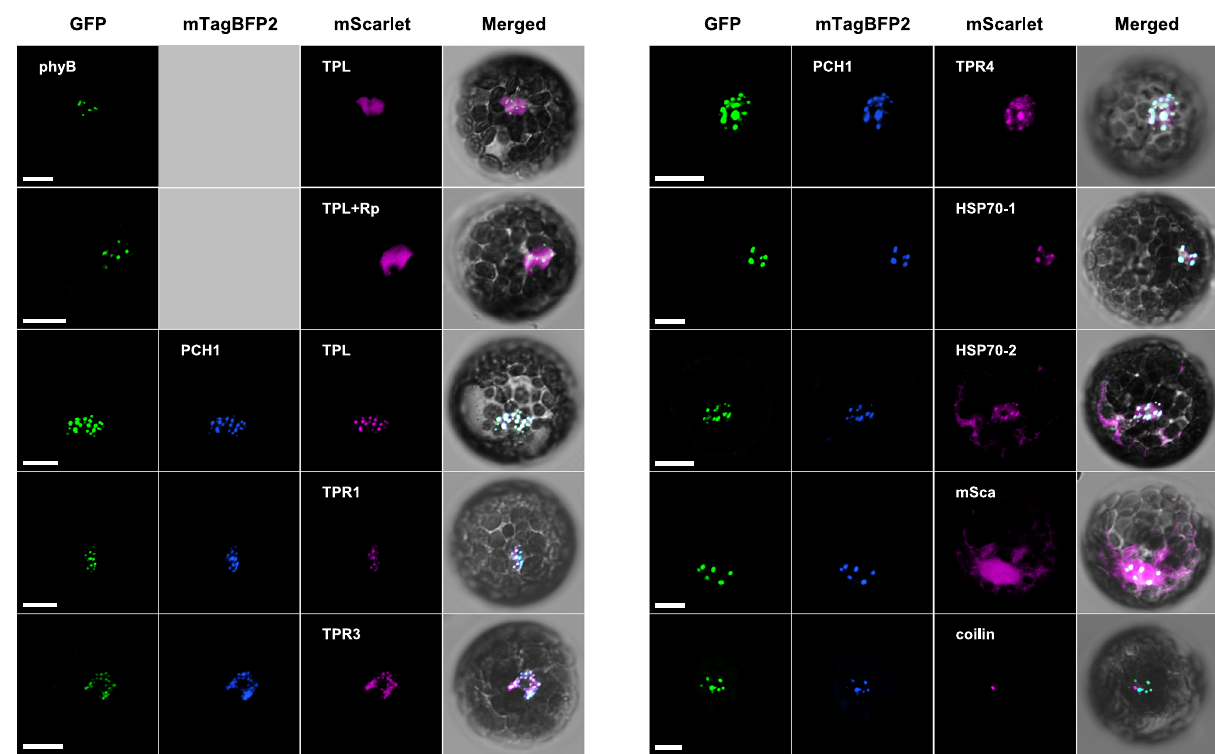
Fig. 4 | PhyB photobody components that localize to the phyB photobody when co-expressed with PCH1. mScarlet-fused candidate proteins were tran- siently co-expressed with mTagBFP2-fused PCH1 in protoplasts prepared from PHYB-GFP transgenicplants.Imagesweretakenunderaconfocalmicroscopeusing the GFP channel (488nm-525/25nm) for phyB-GFP (GFP, green color), the BFP channel (405nm-450/25nm) for PCH1-mTagBFP2 (mTagBFP2, blue color), and the RFP channel (561nm-595/25nm) for mScarlet-fused proteins (mScarlet, magenta color). The fl uorescence images were merged with white light images (Merged). Coilin-mScarlet was used as a control protein that is known to form a phyB-